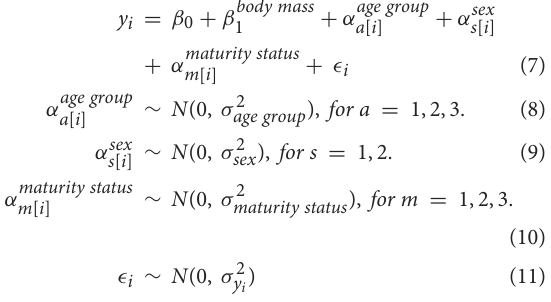
TABLE 1 Distribution of stages of pubic hair (PH) in the sample of adolescents by sex and age group.